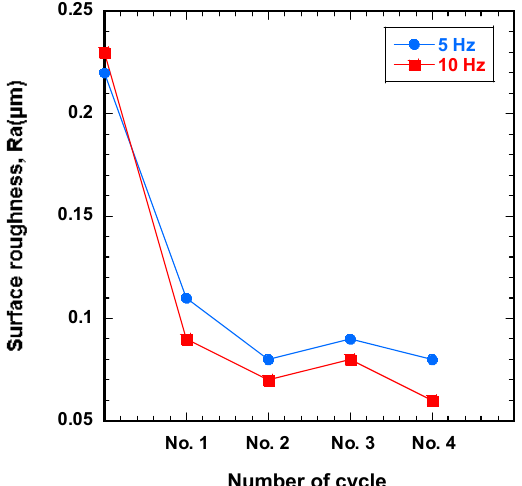
Figure 5. Surface roughness (Ra) as a function of the number of finishing cycles for different magnetic field vibration frequencies with eco-friendly magnetic abrasive tools.